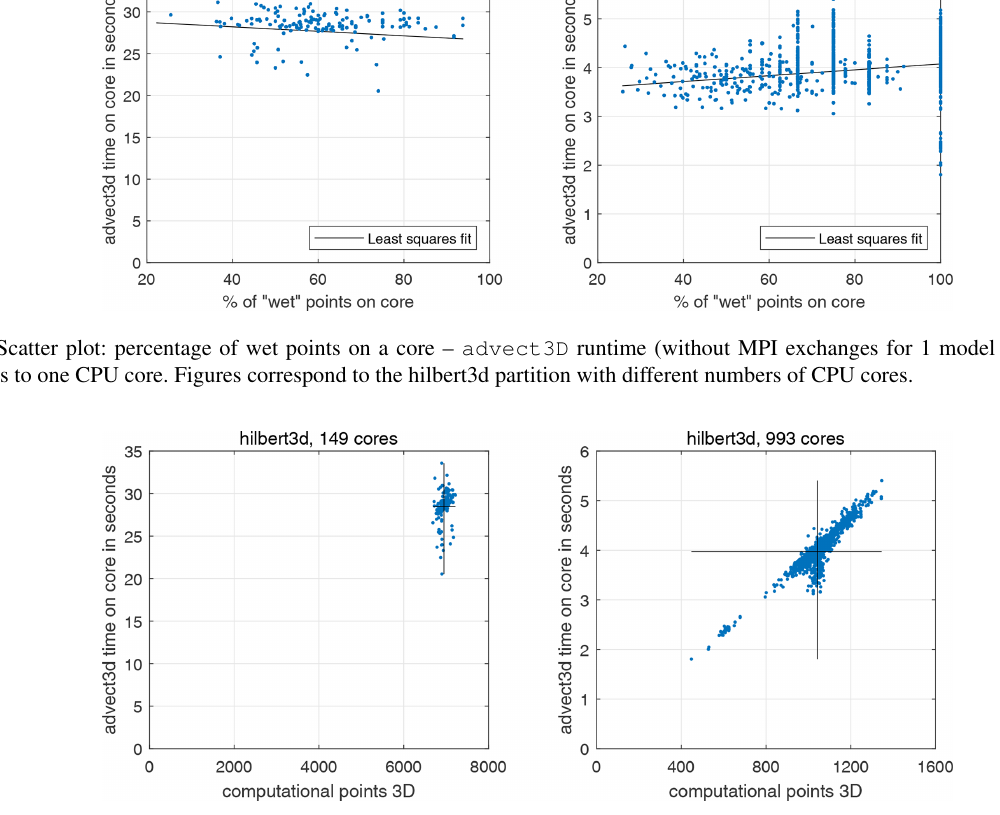
Figure 6. Scatter plot: number of computational points for 3D calculations on a core – advect3D runtime (without MPI exchanges for 1 model day). Each point corresponds to one CPU core. Solid lines show the average values along the x and y axes. Figures correspond to the hilbert3d partition with different numbers of CPU